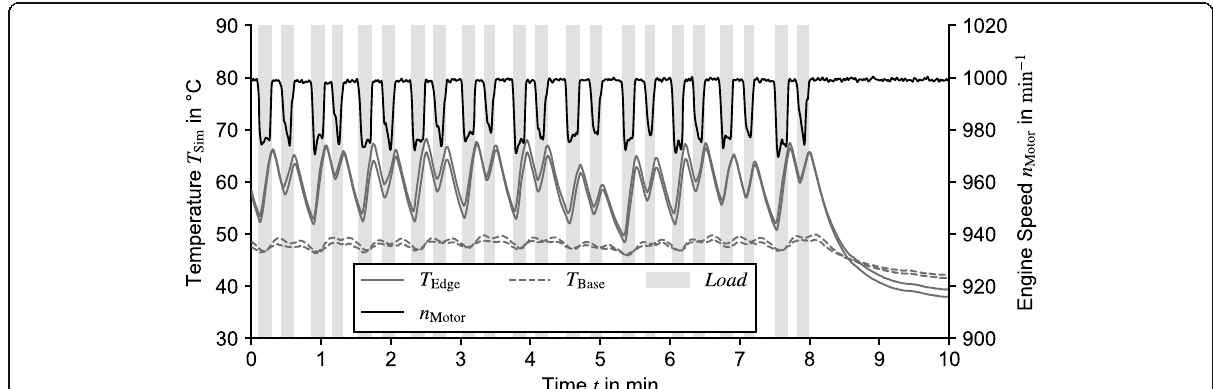
Fig. 7 Temperature and motor speed measurement for Wet White during shaving. Grey lines represent temperatures T Edge close to the edge of the knife and T Base close to the cylindrical roller surface. The black line plots the engine speed n Motor . The grey shaded bars indicate that the machine is under load due to loss in engine speed